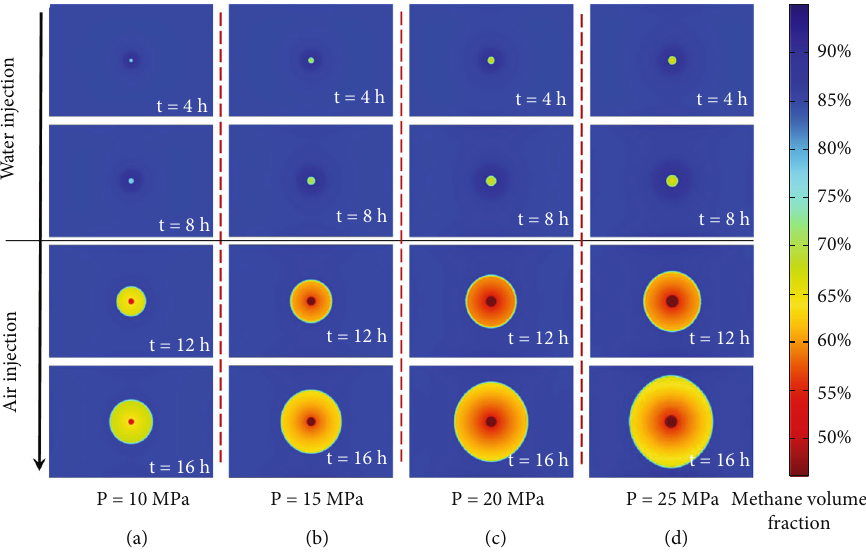
Figure 18: Contour of V